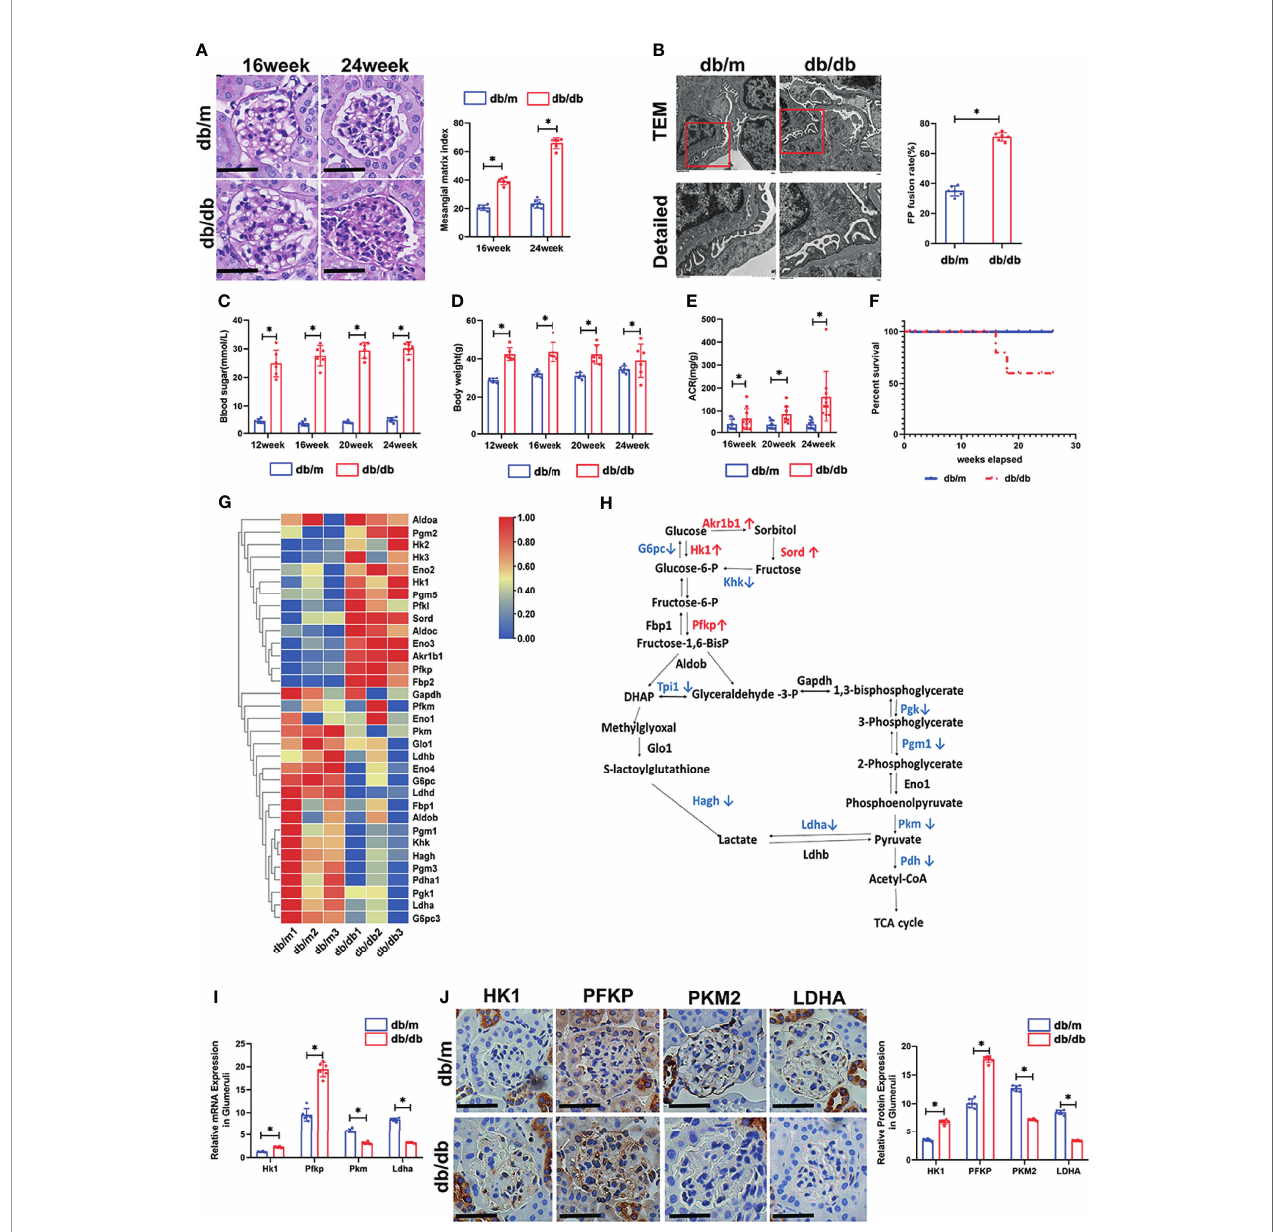
FIGURE 1 | Renal phenotype alteration of db/db mice and pro fi ling of genes involved in glucose catabolism in glomeruli from db/db and db/m mice by mRNA sequencing. (A) Representative microscopy images and quanti fi cation of PAS staining of kidney sections from db/m and db/db mice at 16 and 24 weeks of age (original magni fi cation ×400). (B) Representative fi ndings of the ultrastructure of capillary loops collected from db/m and db/db mice at different timepoints, as examined by transmission electron microscopy (original magni fi cation×8,000, ×12,000). (C) Blood sugar of db/m and db/db mice. (D) Body weight of db/m and db/ db mice. (E) Quantitative analysis of ACR (albumin-to-creatinine ratio) in db/m and db/db mice. (F) Survival curve of db/m and db/db mice over time. (G) Gene expression pro fi les were compared between glomeruli of db/m and db/db mice, and heat maps were generated based on signi fi cantly differential expression of genes related to glucose metabolism. (H) Schematic fl ow illustrating the representative genes in the glycolysis cascade. Red text represents upregulated genes, and blue text represents downregulated genes in the glomeruli of db/db mice in comparison to db/m mice. Akr1b1, aldo-keto reductase family 1, member B1 (aldose reductase); Hk, hexokinase; G6pc, glucose-6-phosphatase, catalytic subunit; Sord, sorbitol dehydrogenase; Pfk, phosphofructokinase; Fbp2, fructose- 1,6-diphosphatase 2; Gapdh, glyceraldehyde 3-phosphate dehydrogenase; Tpi1, triosephosphate isomerase 1; Pgk, phosphoglycerate kinase; Pgm1, phosphoglucomutase-1; Eno1, enolase 1; Pkm, pyruvate kinase isoenzyme; Pdh, pyruvate dehydrogenase; Ldh, lactate dehydrogenase; Hagh, hydroxyacyl glutathione hydrolase; Glo1, glyoxalase 1. (I) Relative mRNA expression of Hk1, Pfkp, Pkm and Ldha in the glomeruli of db/m and db/db mice determined by real-time PCR. (J) Representative immunohistochemistry staining of glomerular HK1, PFKP, PKM2, and LDHA in db/m and db/db mice. For all fi gures, n=6 independent experiments/group. In all statistical plots, * P < 0.05. Scale bars: 20 µm, HK1, hexokinase 1; PFKP, phosphofructokinase 1 platelet type; PKM2, pyruvate kinase isoenzyme 2; LDHA, lactate dehydrogenase